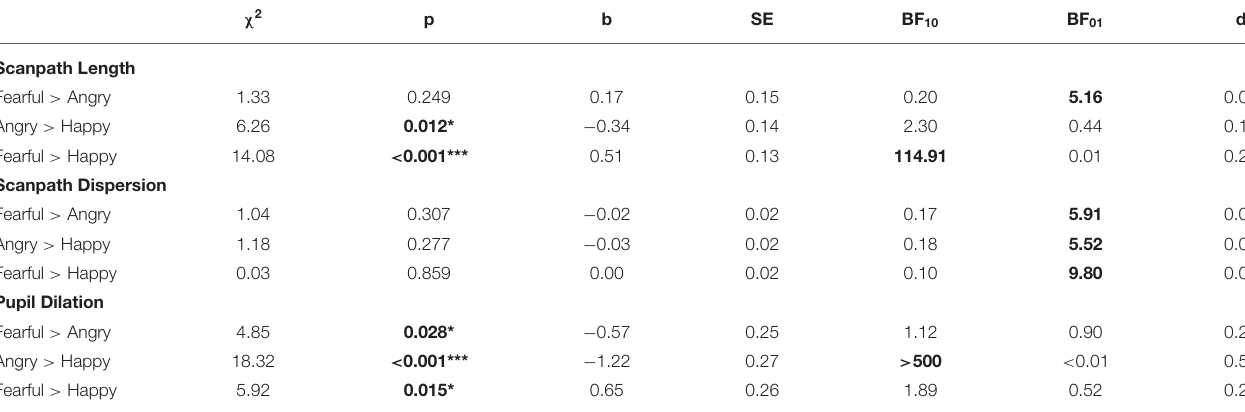
TABLE 2 | Main effects of emotion for the studied dependent variables. χ 2 p b SE BF 10 BF 01